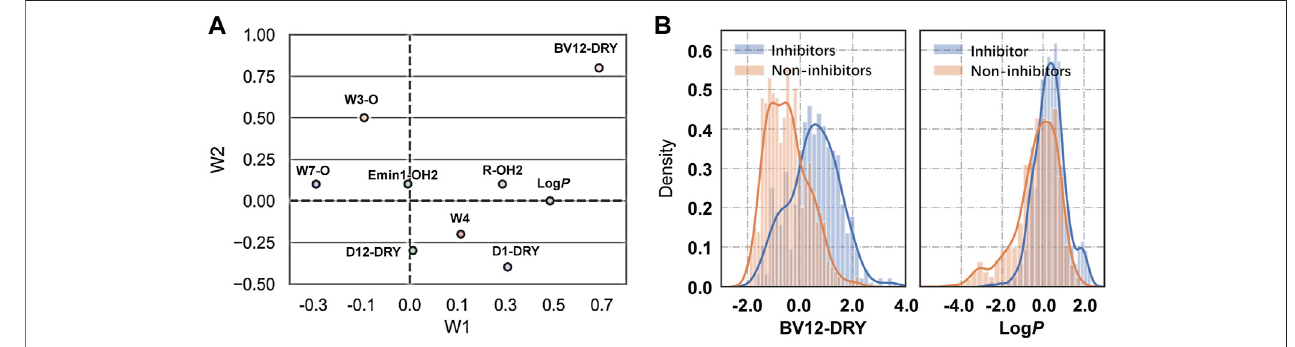
FIGURE 2 | Analysis of VolSurf descriptors. (A) Loadings of the nine independent variables in the fi rst two principal components. (B) Density distribution of the descriptors BV12-DRY ( p = 1.566 × 10 – 69 ) and Log P ( p = 8.054 × 10 – 29 ) in the two classes. The p values were calculated by using Student ’ s t-test.